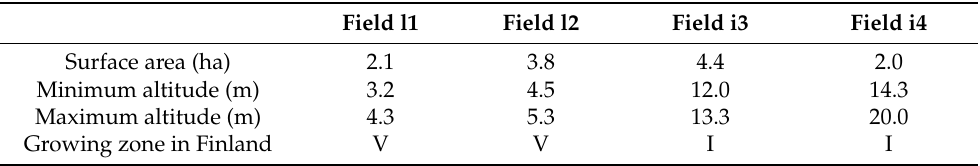
Figure 1. The locations of the study fields in southern and northern Finland (ETRS-TM35FIN). Fields i3 and i4 were located in a hemiboreal climate zone and growing zone I, and fields l1 and l2 were located in a middle boreal climate zone and growing zone V [29,30]. Table 1. Surface area, minimum and maximum elevation (Height System: N2000), and growing zones [30] of the four experimental fields.